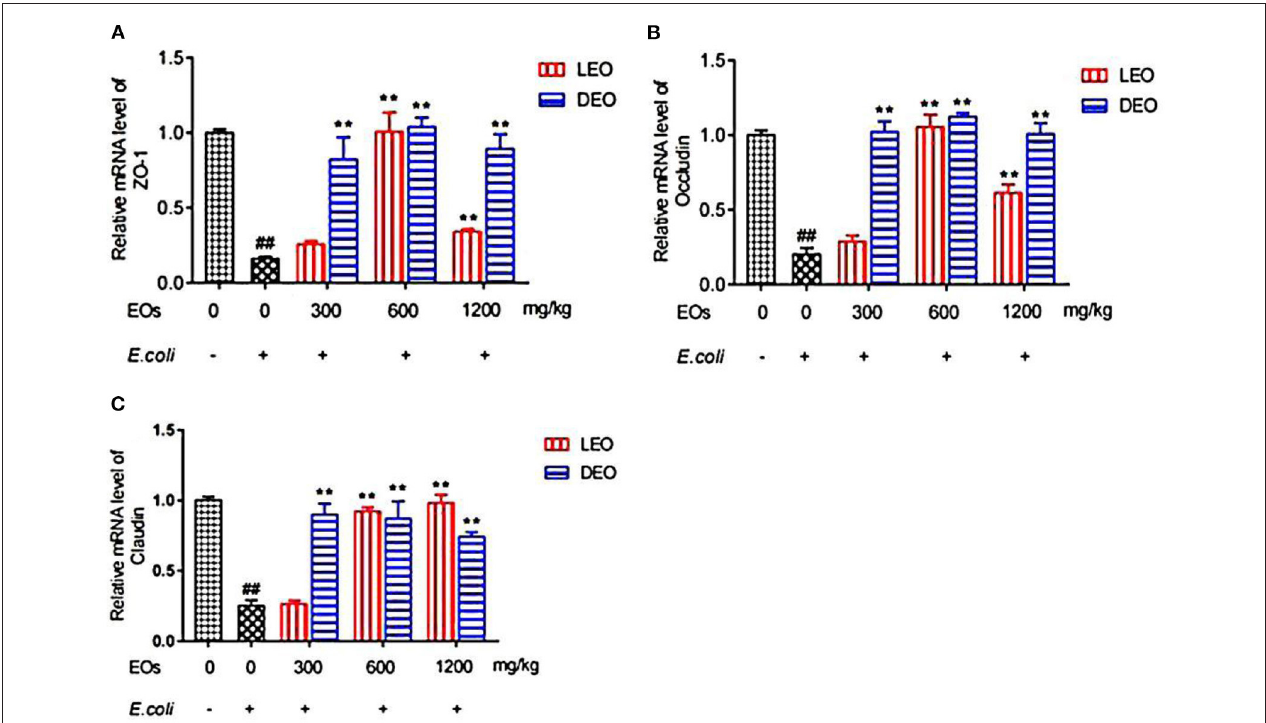
FIGURE 4 | Effects of LEO and DEO on secretion of ZO-1 (A) , occludin (B) and claudin (C) in E. coli injected mice duodenum. Data were presented as mean ± standard error of mean (SEM; n = 8). The 1st column was normal saline group (NS) with no E. coli and no EO. The 2nd column was the E. coli group with no EO. The 3rd − 8th column are the LEO and DEO groups with doses at 300, 600, and 1,200 mg/kg BW, respectively. ## P < 0.01, E. coli group compared with NS group; Essential oil (E) and its different dose (D) had significant effects on duodenal tight junction proteins ( P E < 0.01, P D < 0.01), and their interaction (E × D) was significant ( P E × P D < 0.01). ** P < 0.01, EO groups compared with E. coli group. LEO, lemon essential oil; DEO, d-limonene essential